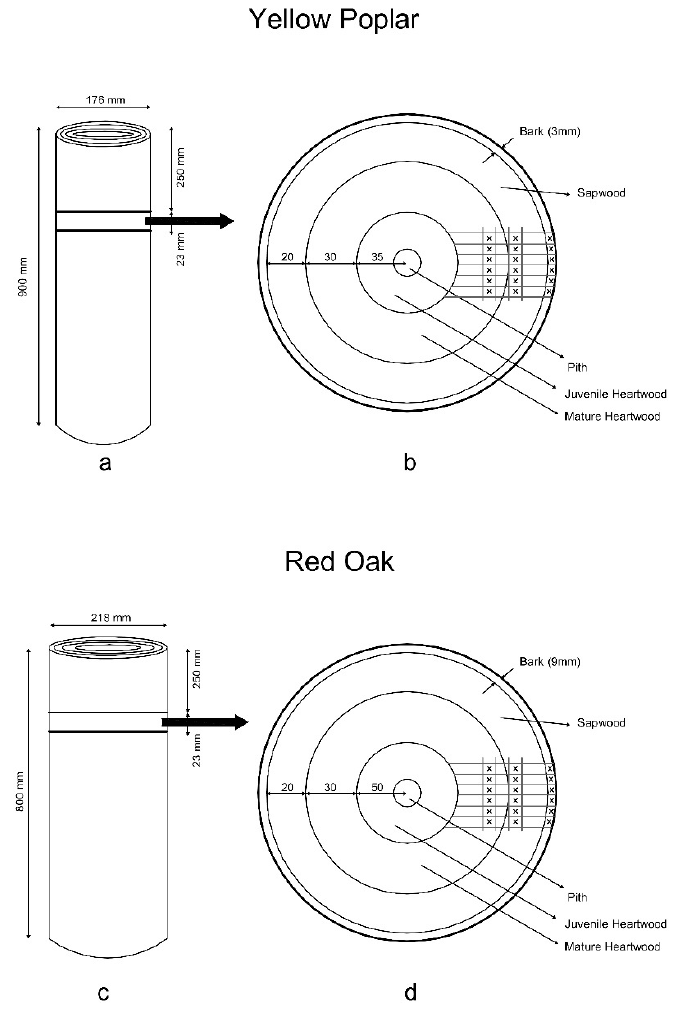
Figure 1. ( a ) Cutting pattern of the yellow-poplar disc from the logs. ( b ) Cutting pattern of the yellow-poplar cubic samples from the discs. ( c ) Cutting pattern of the red oak disc from the logs. ( d ) Cutting pattern of the yellow-poplar cubic samples from the discs.